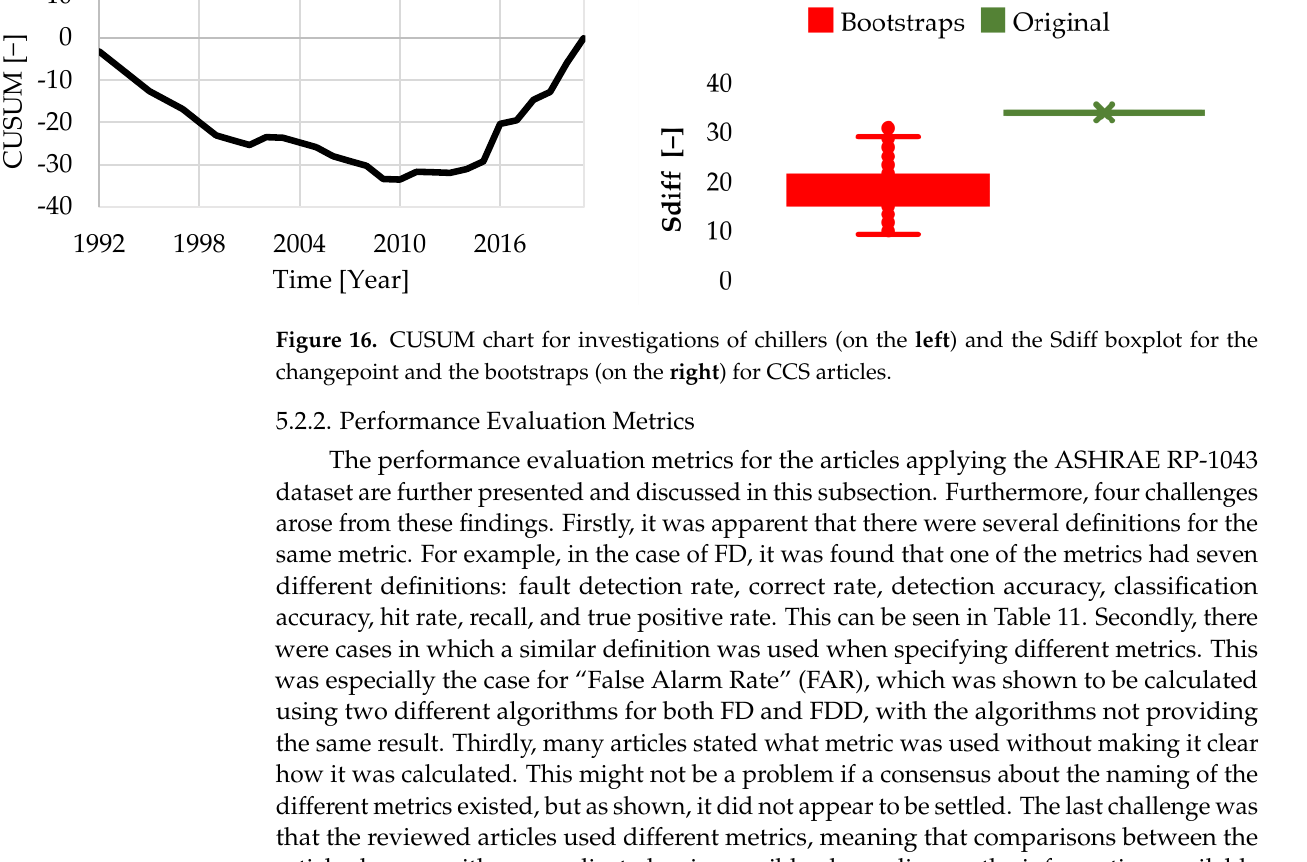
23 of 51 Figure 15. Number of publications on CCS and datasets used. Black: total number of publications on CCS per year. Yellow: the sum of the presented datasets. Green: number of articles on CCS using the ASHRAE RP-1043 dataset. Red: number of articles on CCS using the electric factory dataset. The green and red arrows indicate when the ASHRAE RP-1043 dataset and the electric factory dataset, respectively, became publicly available. A cumulative sum chart (CUSUM) analysis performed on the data in Figure 15 indi- cated a sharp and significant increase in the number of publications after the release of these two datasets, as can be seen in Figure 16. A changepoint analysis was performed